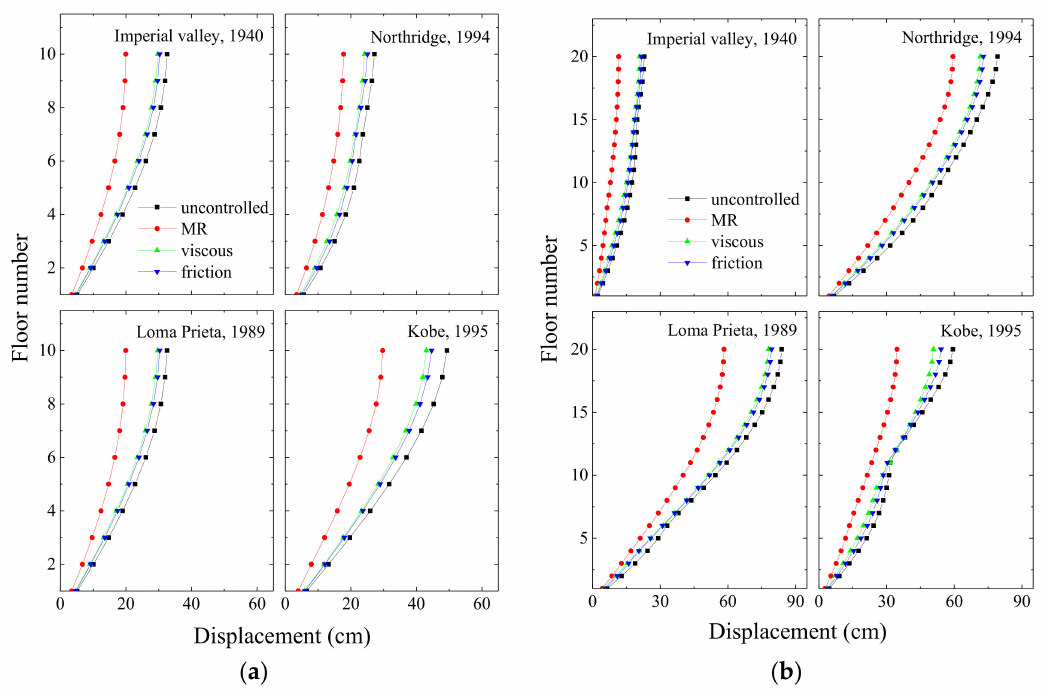
Figure 17. Peak floor displacement response of: ( a ) a coupled stiff building and ( b ) a coupled flexible building when they are connected with different types of dampers arranged in Configuration 1.